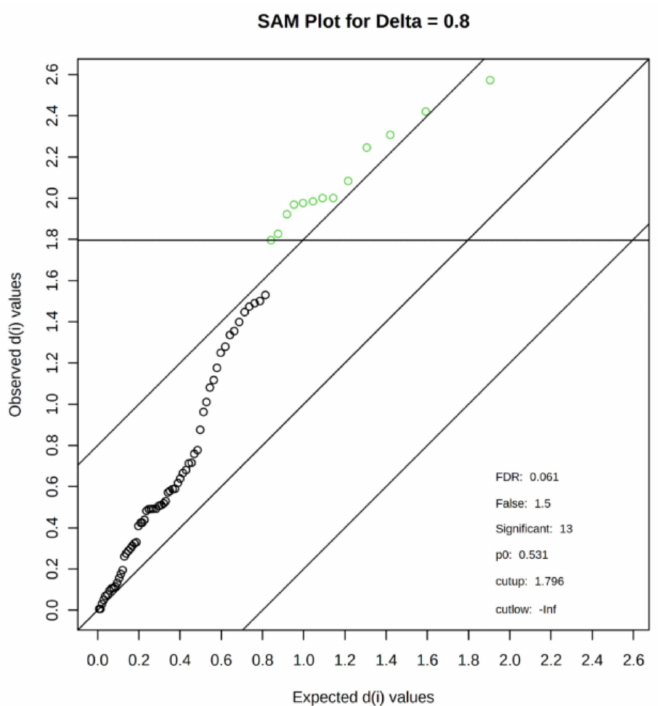
Figure A1. Results of SAM analysis for all study subjects (N = 38).